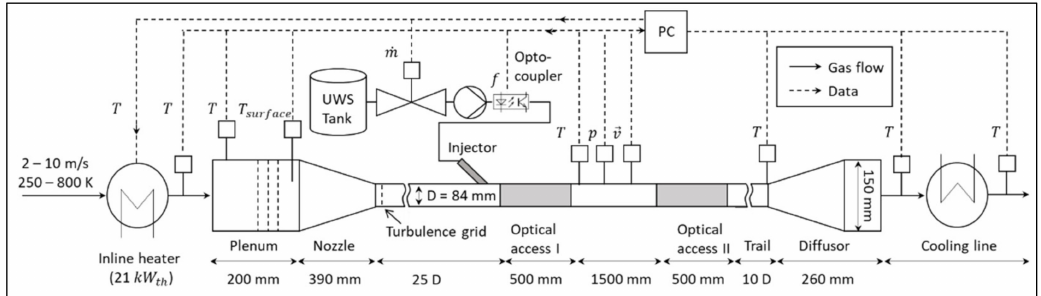
Figure 2. Schematic layout of the generic exhaust gas test bench. The plenum, the inflow nozzle and the 25 D-long inlayed pipe are designed with integrated turbulence grids to prepare the flow. The injection is placed close to the “optical access I”, where the reported measurements took